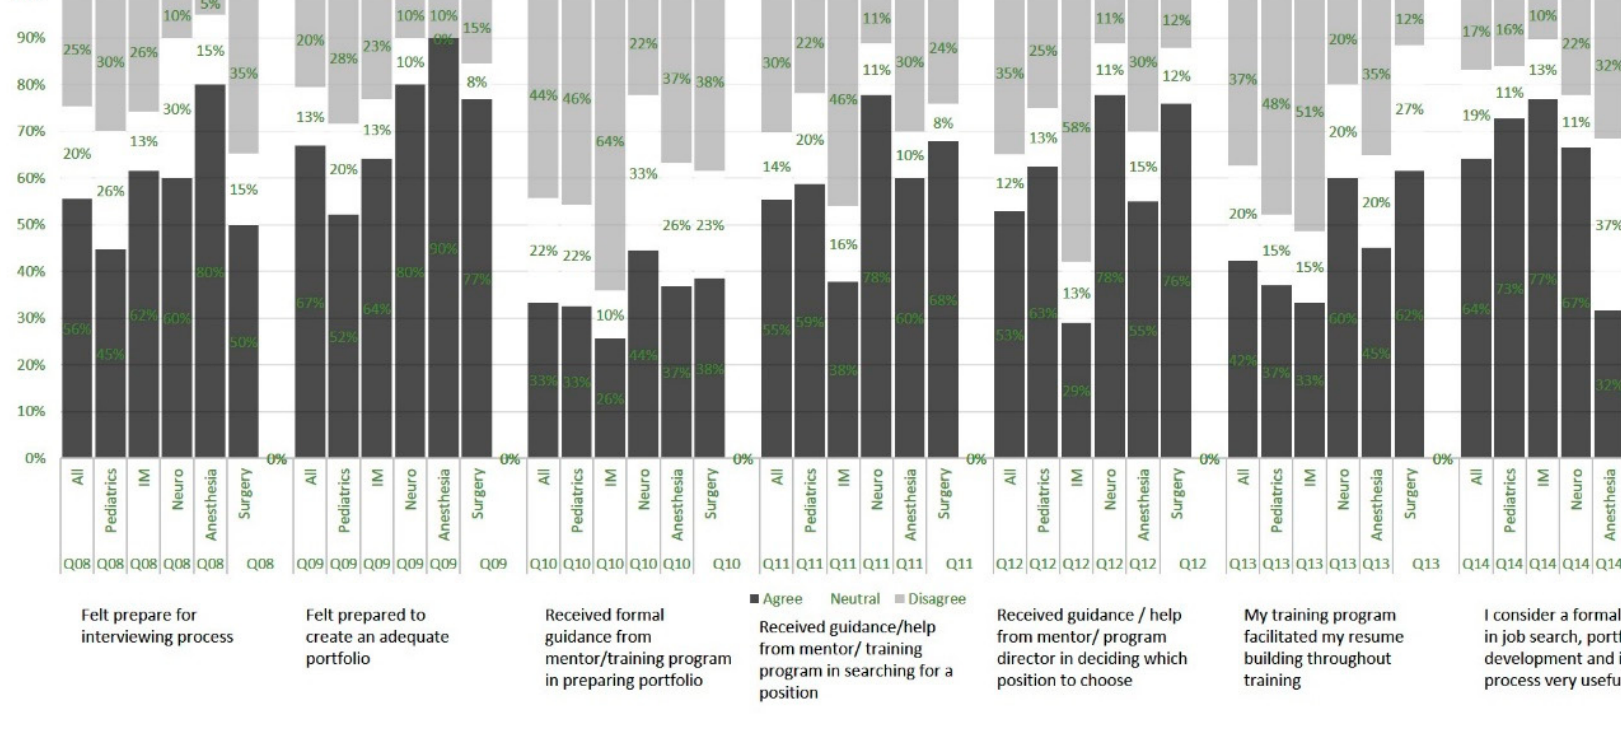
Figure 3. Likert scale responses by specialty.